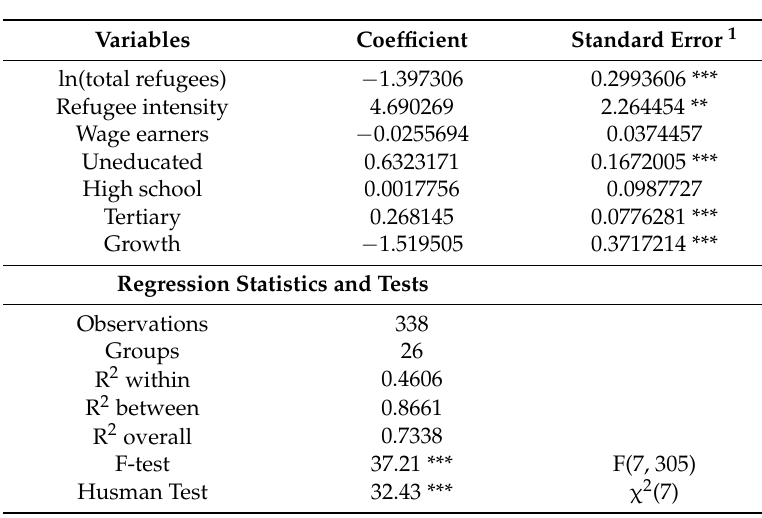
Table 3. Regression results: The determinants of